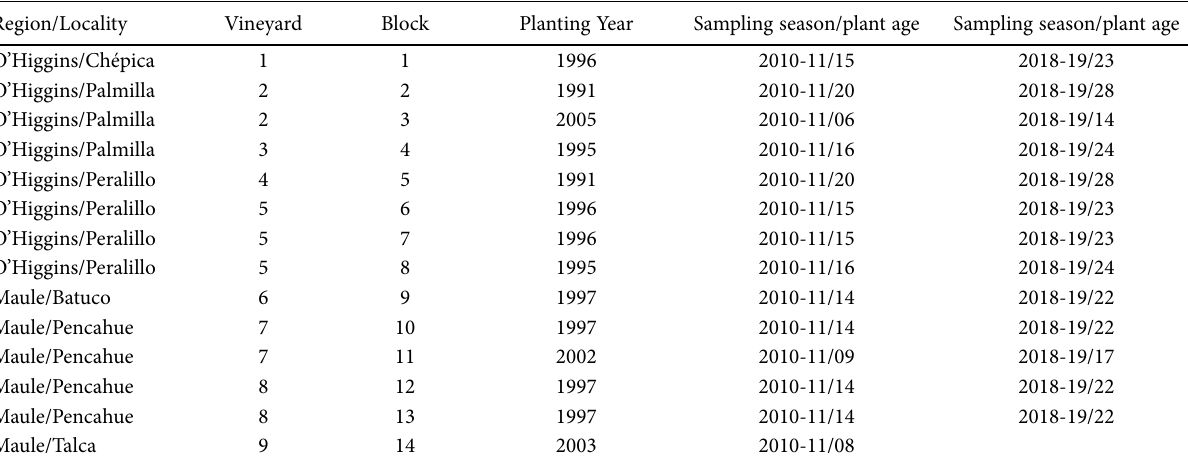
Table 1. Vineyards and blocks ‘Cabernet Sauvignon’ analyzed, located in Central Chile. Region/Locality Vineyard